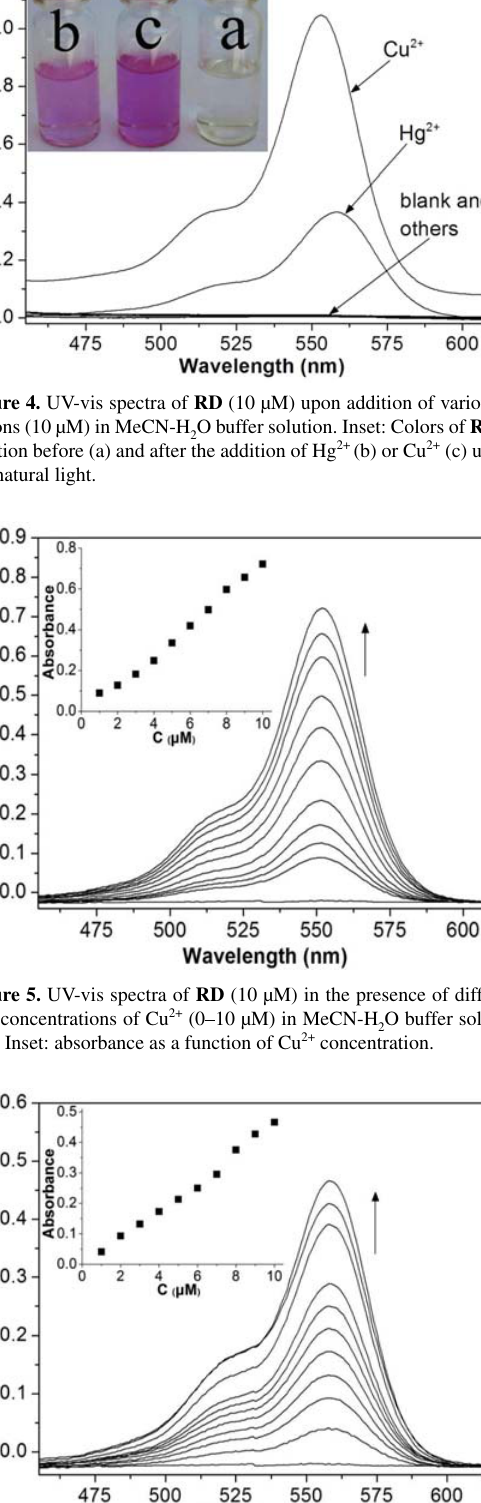
O buffer solu- 2